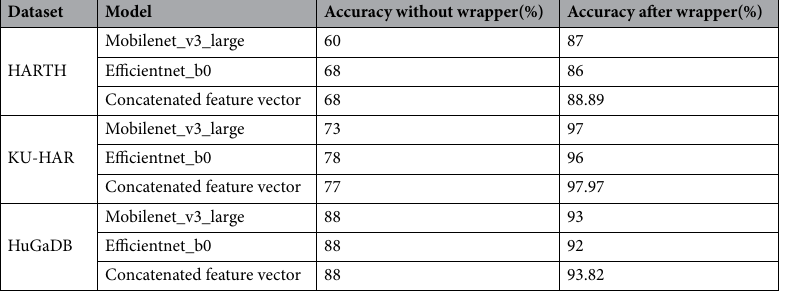
Table 6. Classification accuracies attained for each HAR datasets before and after applying BBA based feature subset selection.